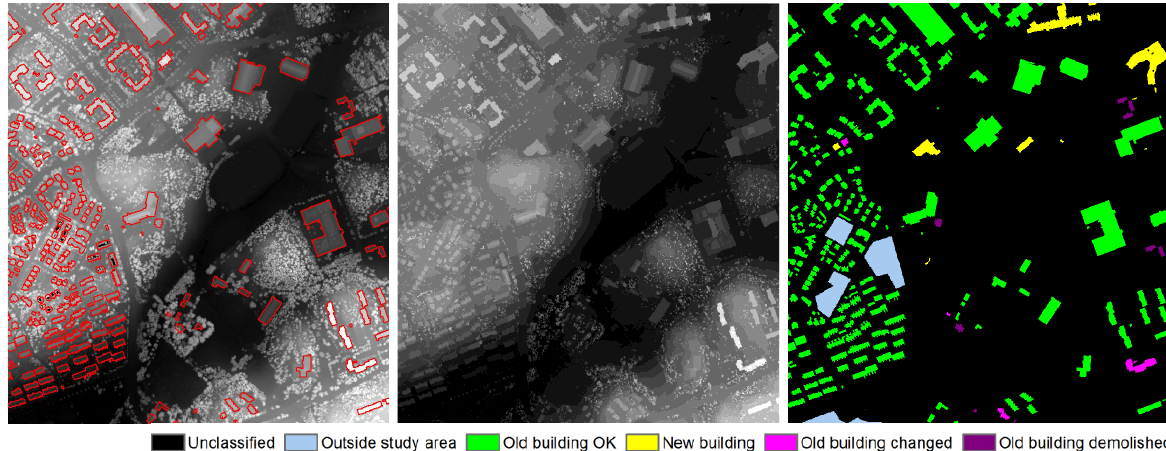
Figure 6. Automated change detection for buildings. The figure shows the old DSM and old building vectors (left), the new DSM (middle), and the change detection result (right). The legend applies to the change detection result. Some areas were excluded from the change detection analysis due to missing data in the old DSM. Original building vectors © the City of Espoo (edited by the